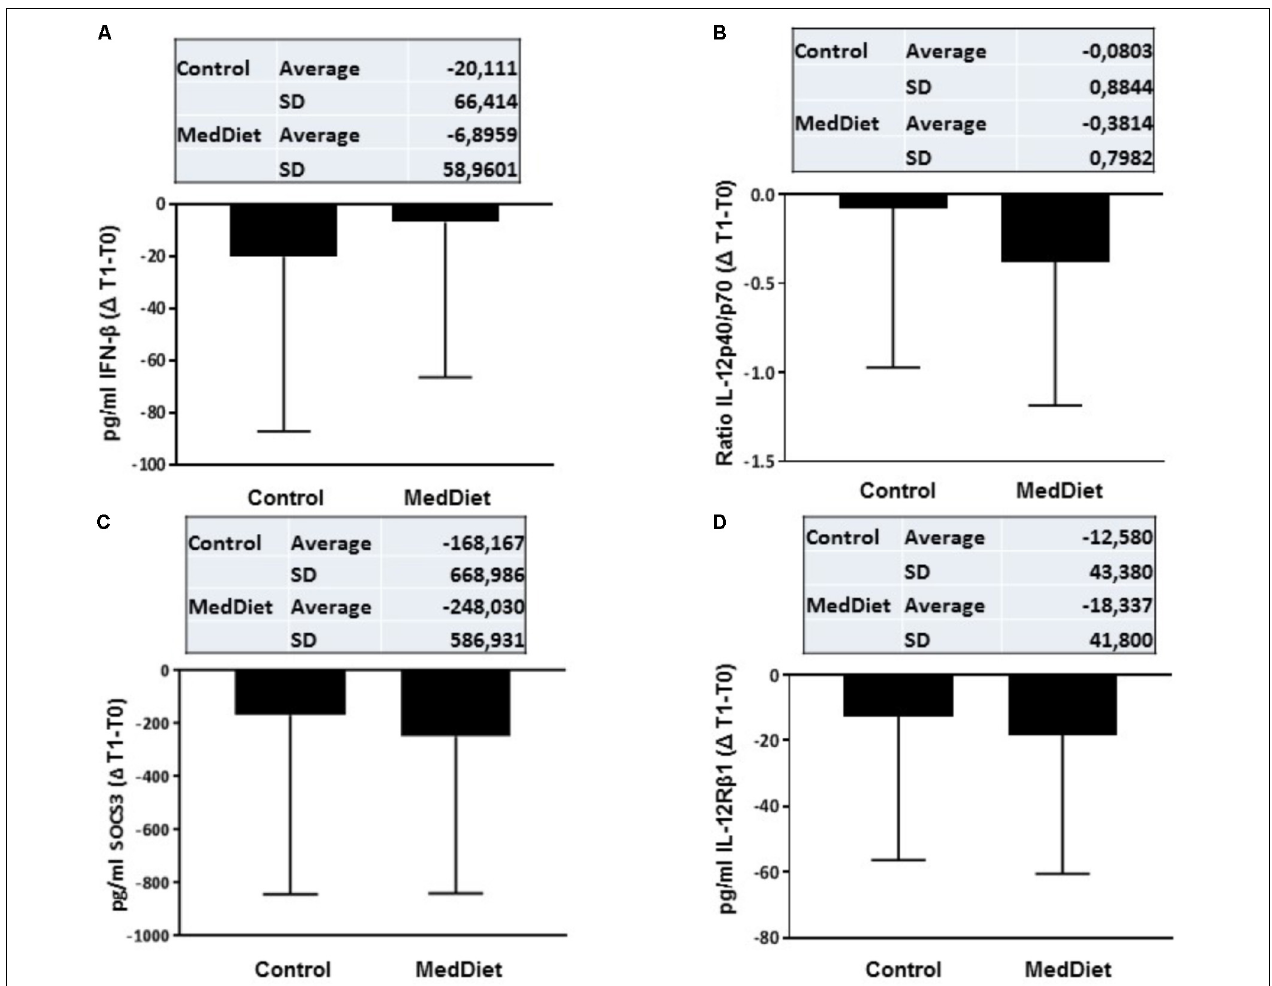
FIGURE 4 | Cytokine expression following in vitro challenge with TLR agonists- Changes ( (cid:49) ) of the parameter values in MedDiet and control diet at baseline and after 1-year of intervention. (cid:49) of the parameters at baseline (T0) and after 1-year (T1) for IFN- β (A) , IL-12p40/70 ratio (B) , SOCS3 (C) , and IL-12R β 1 (D) concentration were calculated and compared. For each parameter, the mean ± SD of the (cid:49) at T0 and T1 for the control group and MedDiet group is shown in the relevant inset.